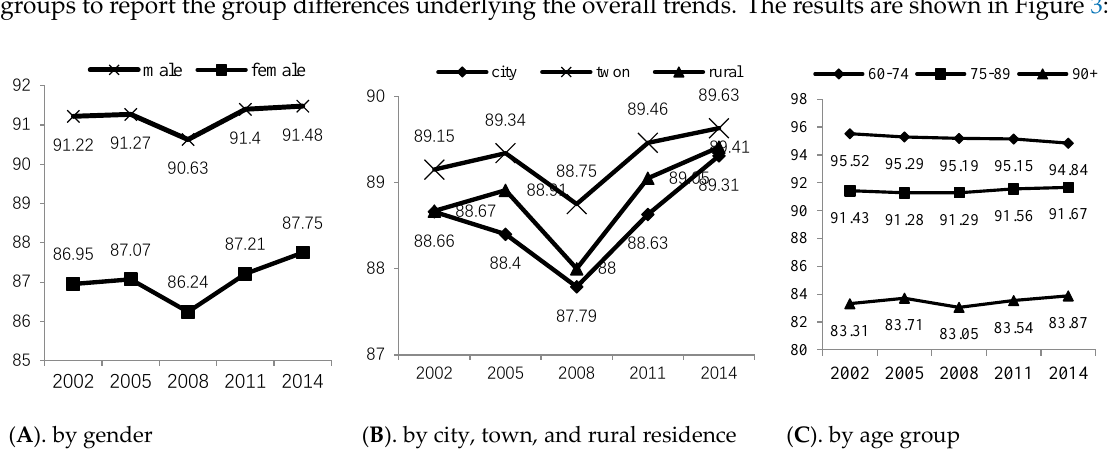
Figure 3. The predicted mean values of Health_elder in five periods.